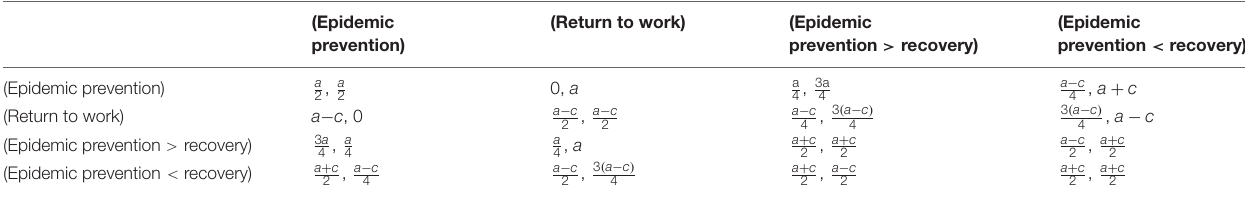
TABLE 3 | Matrices of fitness for the four-strategy